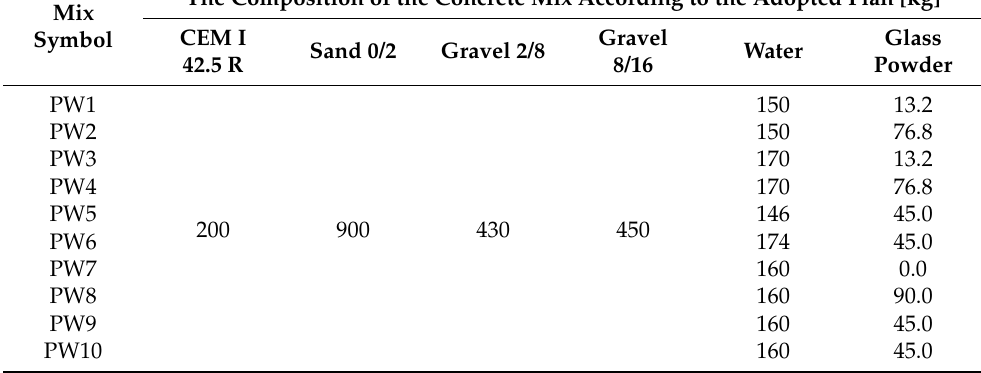
Table 2. Specifications of the tested concrete mixes.